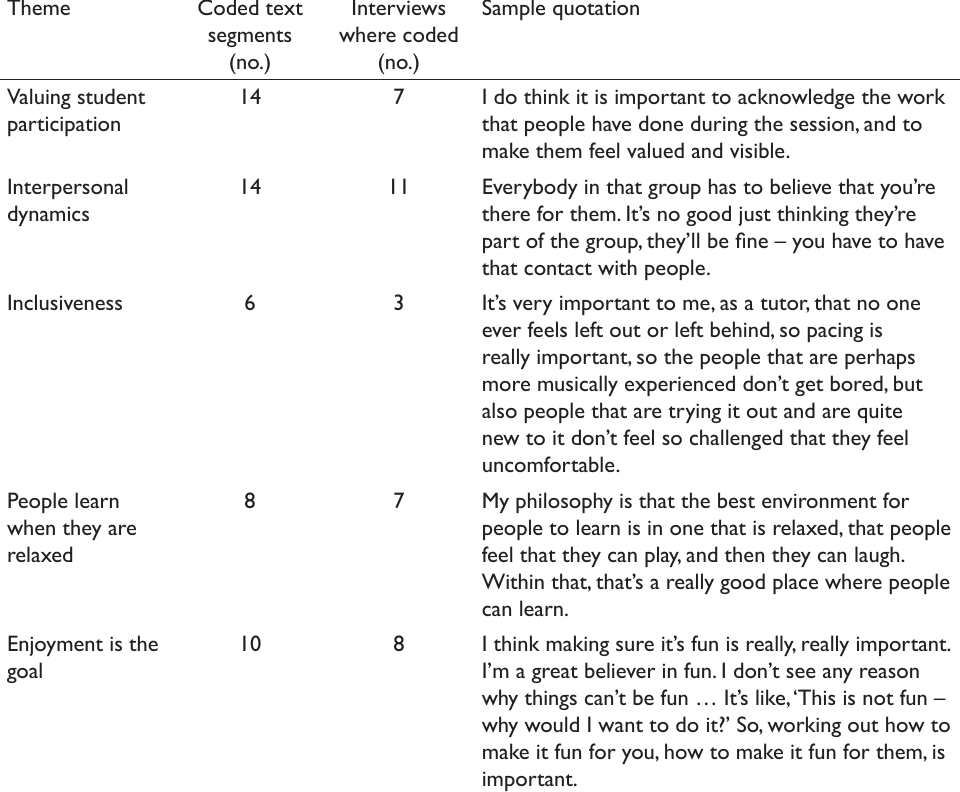
Table 2: Supporting fellow-centred